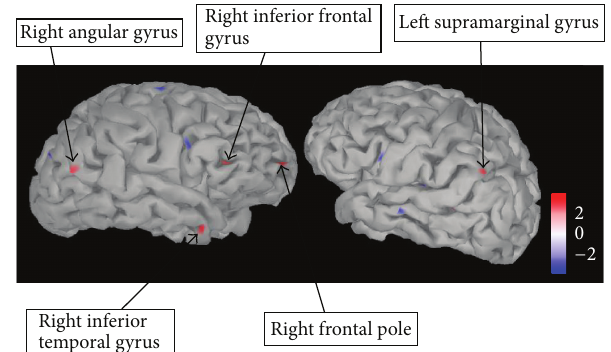
Figure 5: Regions showing significantly higher activation in the AN-C compared to AN-R group 150 ms after stimulus. Regions showing significantly higher activation in a 𝑡 -test comparing the AN-C and AN-R group (shown in red) at 150ms after stimulus (all food pictures versus baseline). Regions were identified by eye and are uncorrected for multiple comparisons ( 𝑝 = 0.005 ). Scale shown represents the 𝑡 -value. AN-C: current Anorexia Nervosa group, AN- R: recovered Anorexia Nervosa